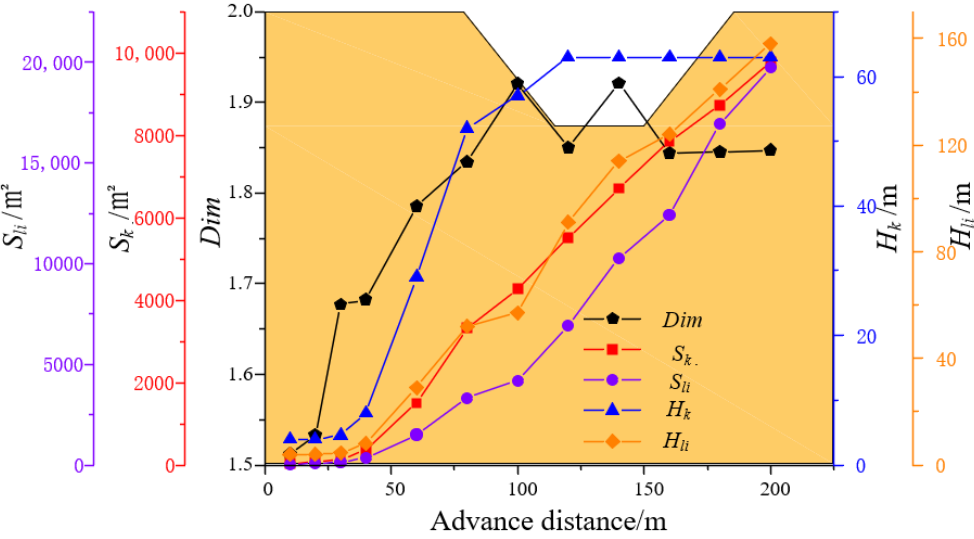
Figure 6. Fractal characteristics of overlying fracture evolution of model 2.